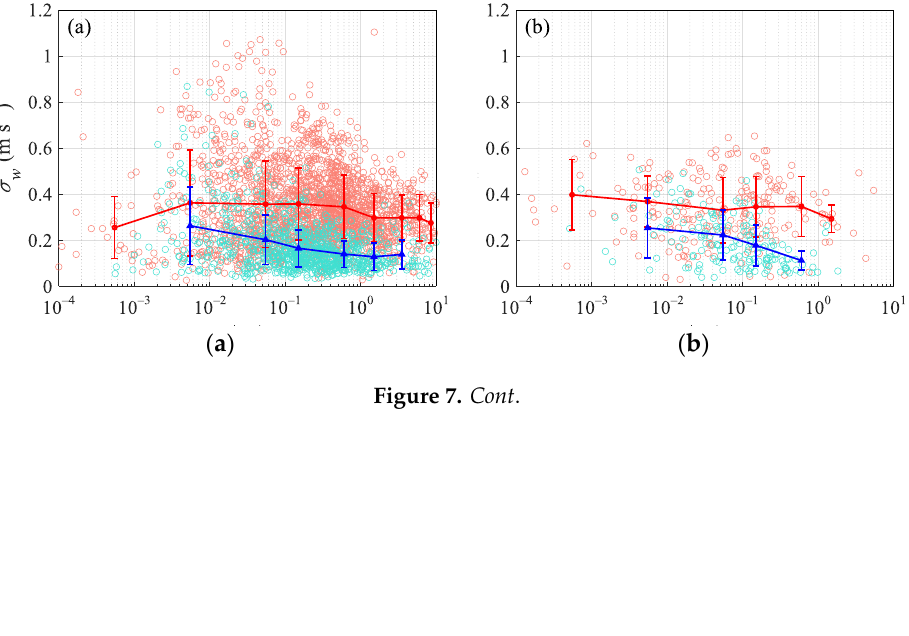
Figure 6. The dependence of the horizontal longitudinal wind standard deviation, σ u , on the stratification stability Ri ( a ) northwest, ( b ) northeast, ( c ) southwest, ( d ) southeast. The scattered points represent the average value of each record. The curves represent the average value of different Ri intervals, and the error bars represent the standard deviation of each interval. The unstable and stable conditions are indicated in red and blue colors, respectively.